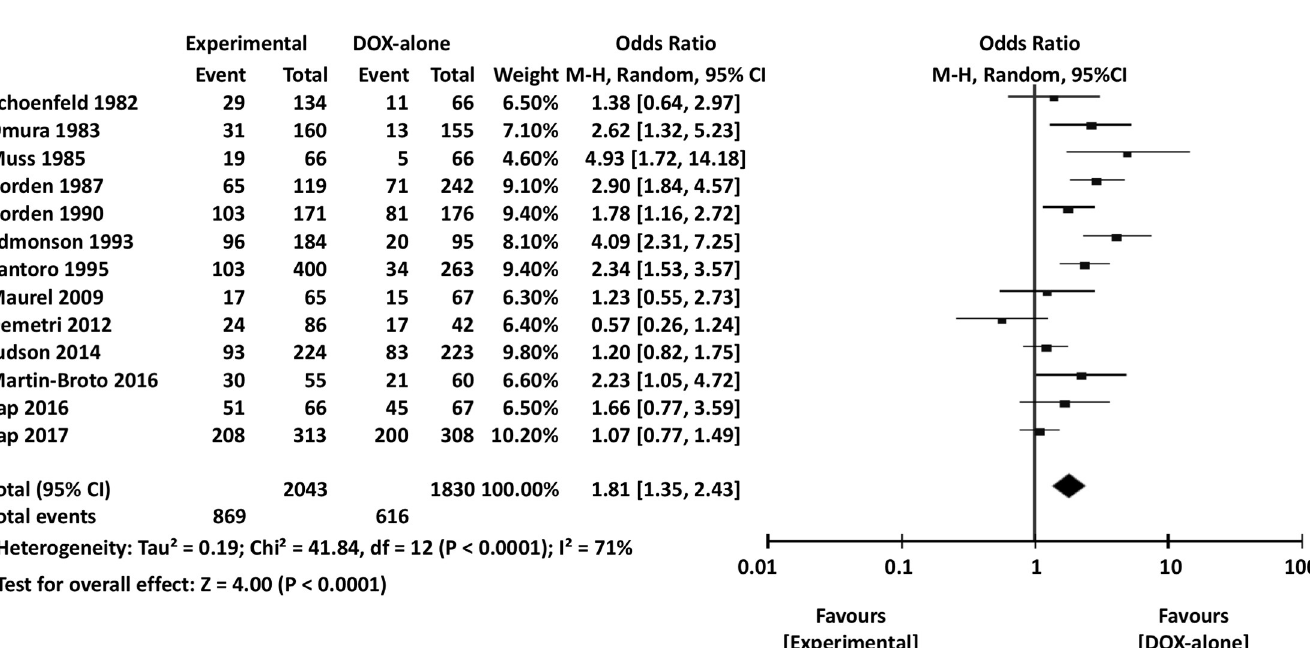
PLOS ONE | https://doi.org/10.1371/journal.pone.0210671 January 10,